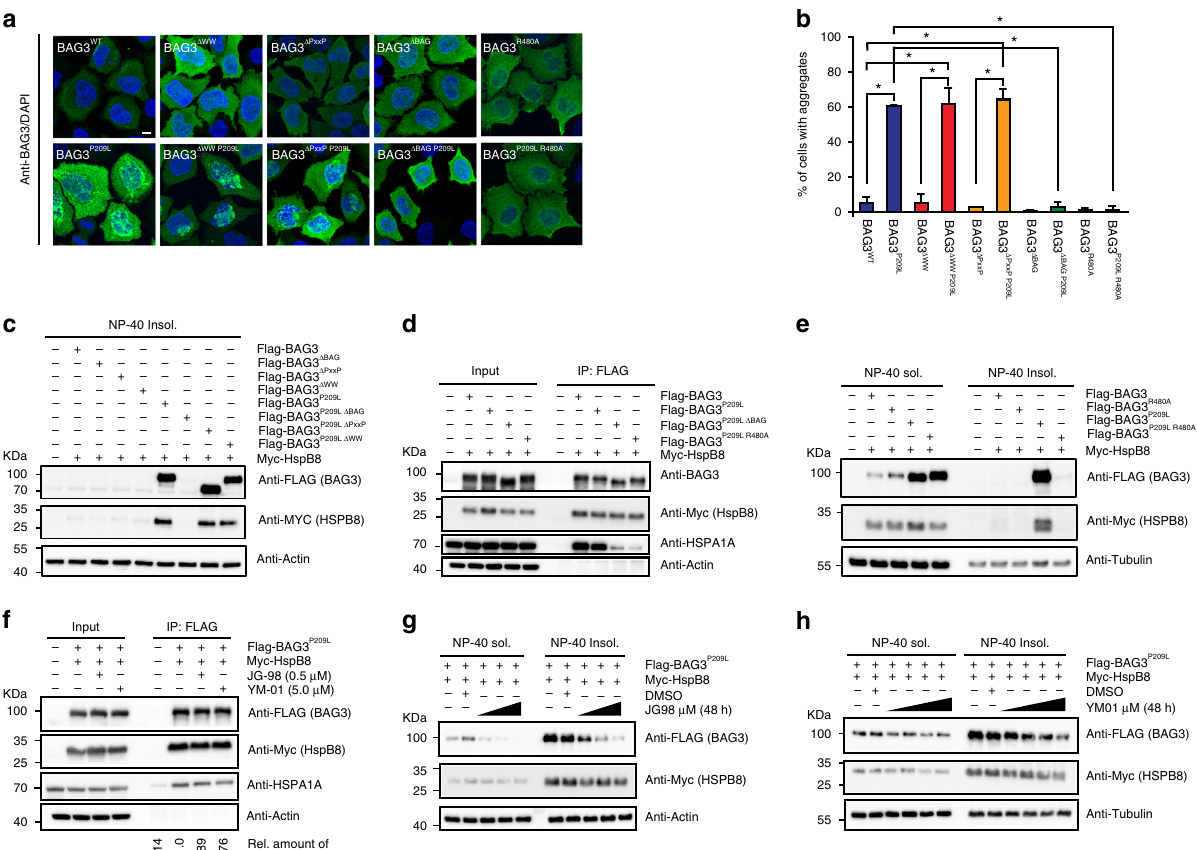
Fig. 5 BAG3 P209L aggregation requires an interaction with Hsp70. a Immuno fl uorescence images of HeLa cells expressing FLAG-BAG3 wt and indicated mutants using an antibody recognizing BAG3 (green). Scale bar = 5 μ m. b Quanti fi cation of the fraction of HeLa cells expressing the indicated BAG3 variants with immuno fl uorescence detectable punctae (2 experiments, at least 100 cells were counted per experiment, error bars represent SD, Welch t test was used to calculate the P values, * indicates P < 0.05). c Western blot of the NP-40 insoluble fraction of HEK293 cells expressing BAG3 wt and indicated variants of BAG3. d Immunoprecipitation of FLAG-BAG3 variants from HEK293 cells expressing both Myc-HSPB8 and indicated FLAG-BAG3 variants. Western blots using the indicated antibodies is shown. e Western blot of NP-40 soluble and insoluble fractions of HEK293 cells expressing indicated BAG3 variants; FLAG (BAG3), Myc (HSPB8), and tubulin antibodies were used. f Western blot of immunoprecipitates using anti FLAG beads from HEK293 cells expressing both FLAG-BAG3 P209L and Myc-HSPB8 in cells treated with either 0.5 μ M JG-98, 5 μ M YM-01 or DMSO; FLAG (BAG3), Myc (HSPB8), HSPA1A, and actin antibodies were used. g , h Western blot of NP-40 soluble and insoluble fractions of HEK293 cells expressing both FLAG- BAG3 P209L and Myc-HSPB8, treated with DMSO or increasing concentration of the drug JG-98 (0.25, 0.5, or 1.0 µ M) ( g ) or YM-01 (1.25, 2.5, 5.0, or 10 µ M) ( h ). Source data are provided as a Source data fi